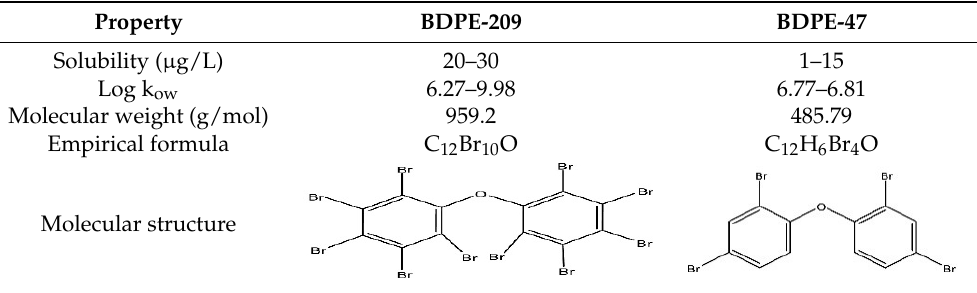
Table 1. Important properties of the PBDPEs used in the present work.